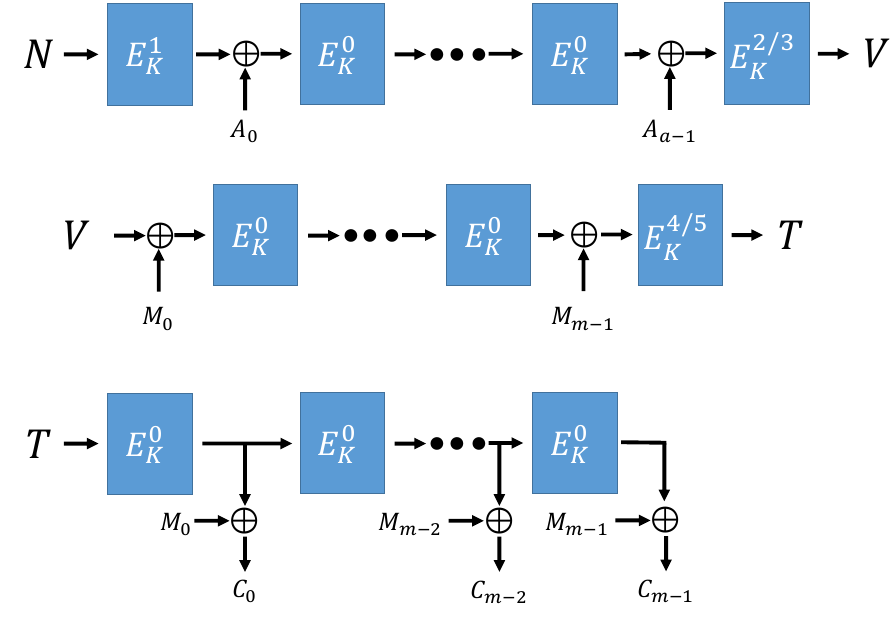
Figure 6. ESTATE mode (Using AD and Message) [16].